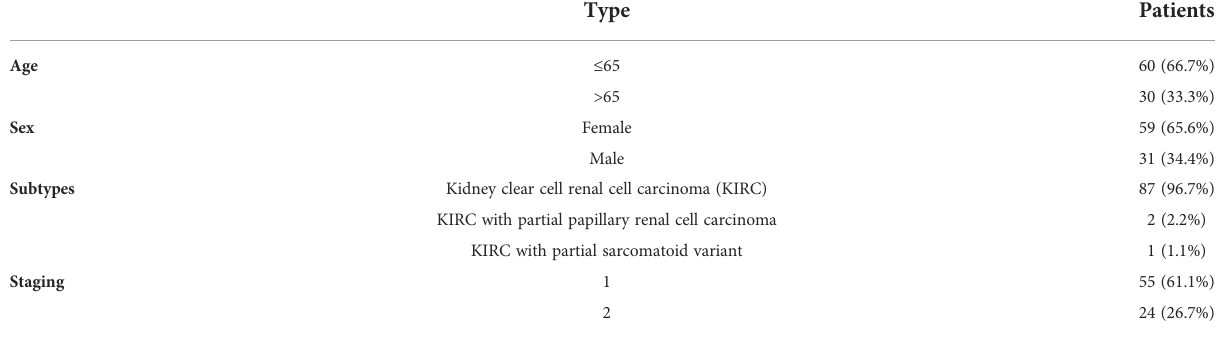
TABLE 1 The characteristics of 90 kidney cancer patients of self-built Chinese